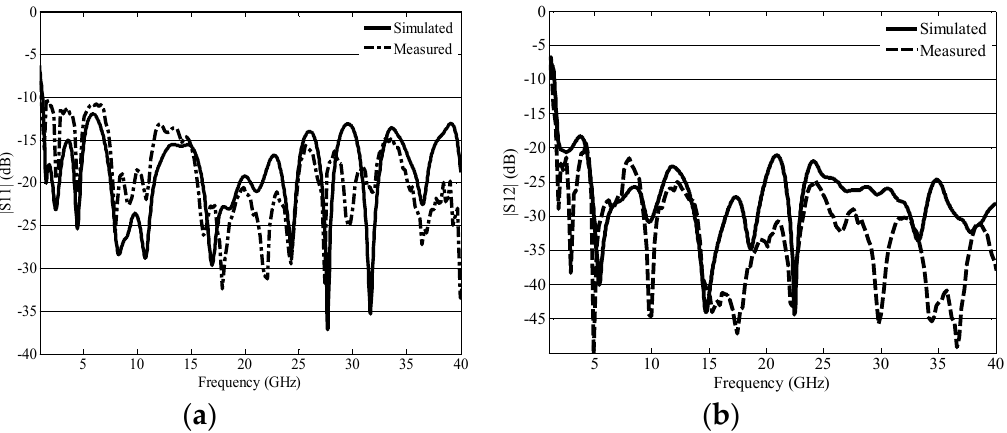
Figure 7. Simulated and measured S-parameters ( a ) S11 ( b ) S21 with t-shape corrugated parasitic element.